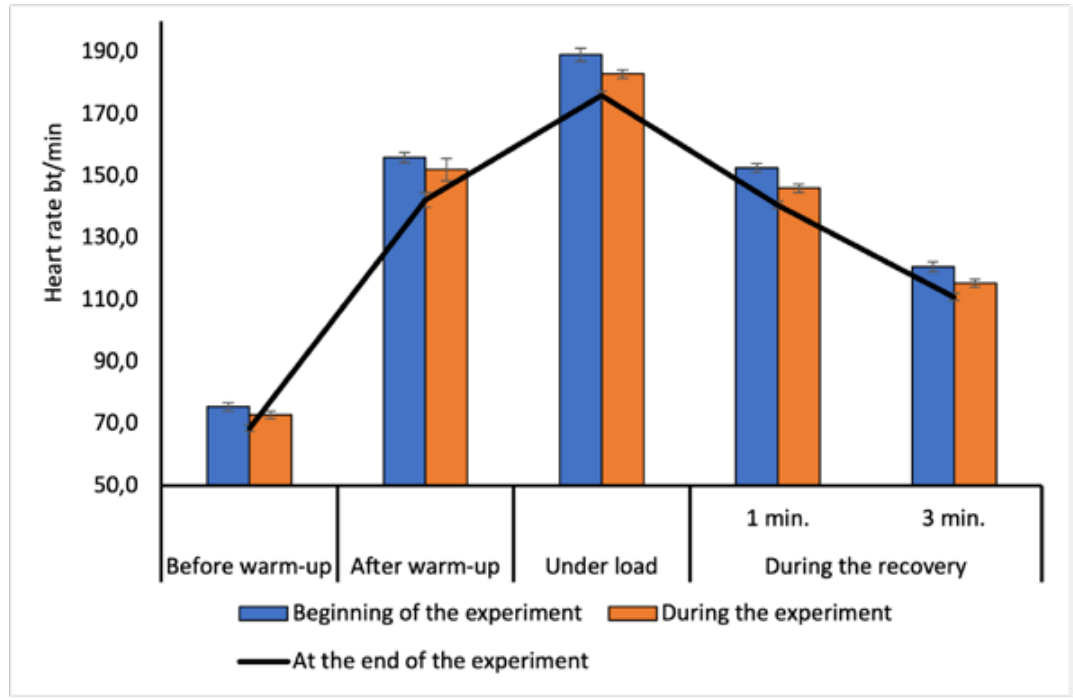
Figure 1. Changes of HR in different physiological states during muscular activity – at the beginning, during, and at the end of the experiment